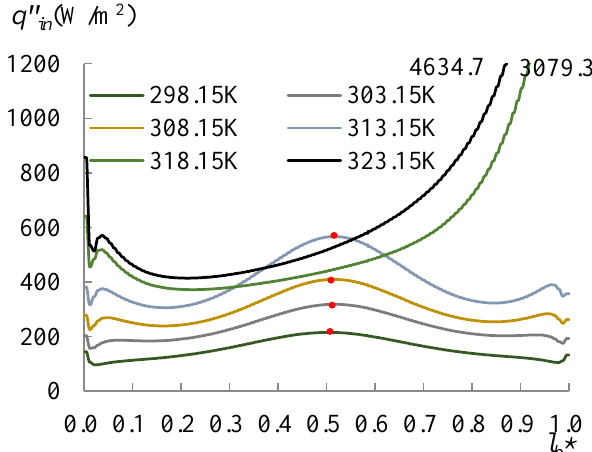
Figure 11. Heat flux conducted from the substrate. The heat conducted from the substrate is inversely proportional to the surface temperature of the droplet, however the dividing points still follow those of the surface temperature.